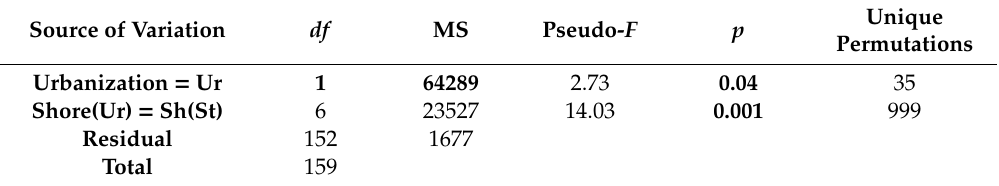
Table 2. Permutational multivariate analysis of variance (PERMANOVA) on canopy assemblages from urban and non-urban shores. Significant effects are indicated in bold.